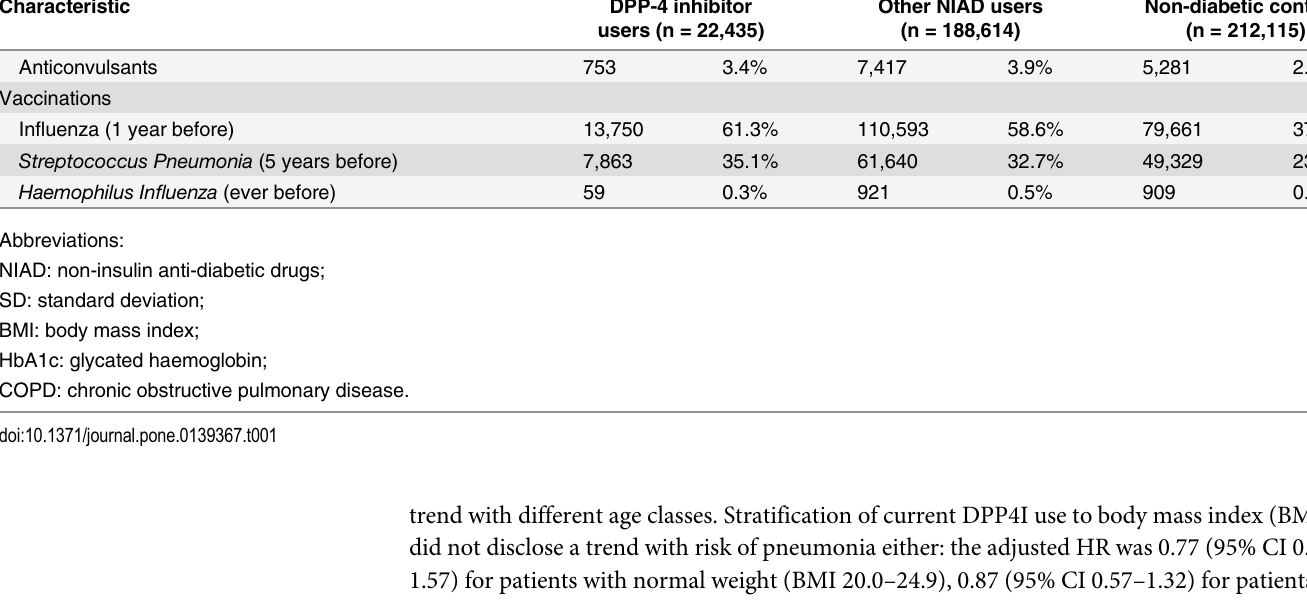
trend with different age classes. Stratification of current DPP4I use to body mass index (BMI) did not disclose a trend with risk of pneumonia either: the adjusted HR was 0.77 (95% CI 0.38